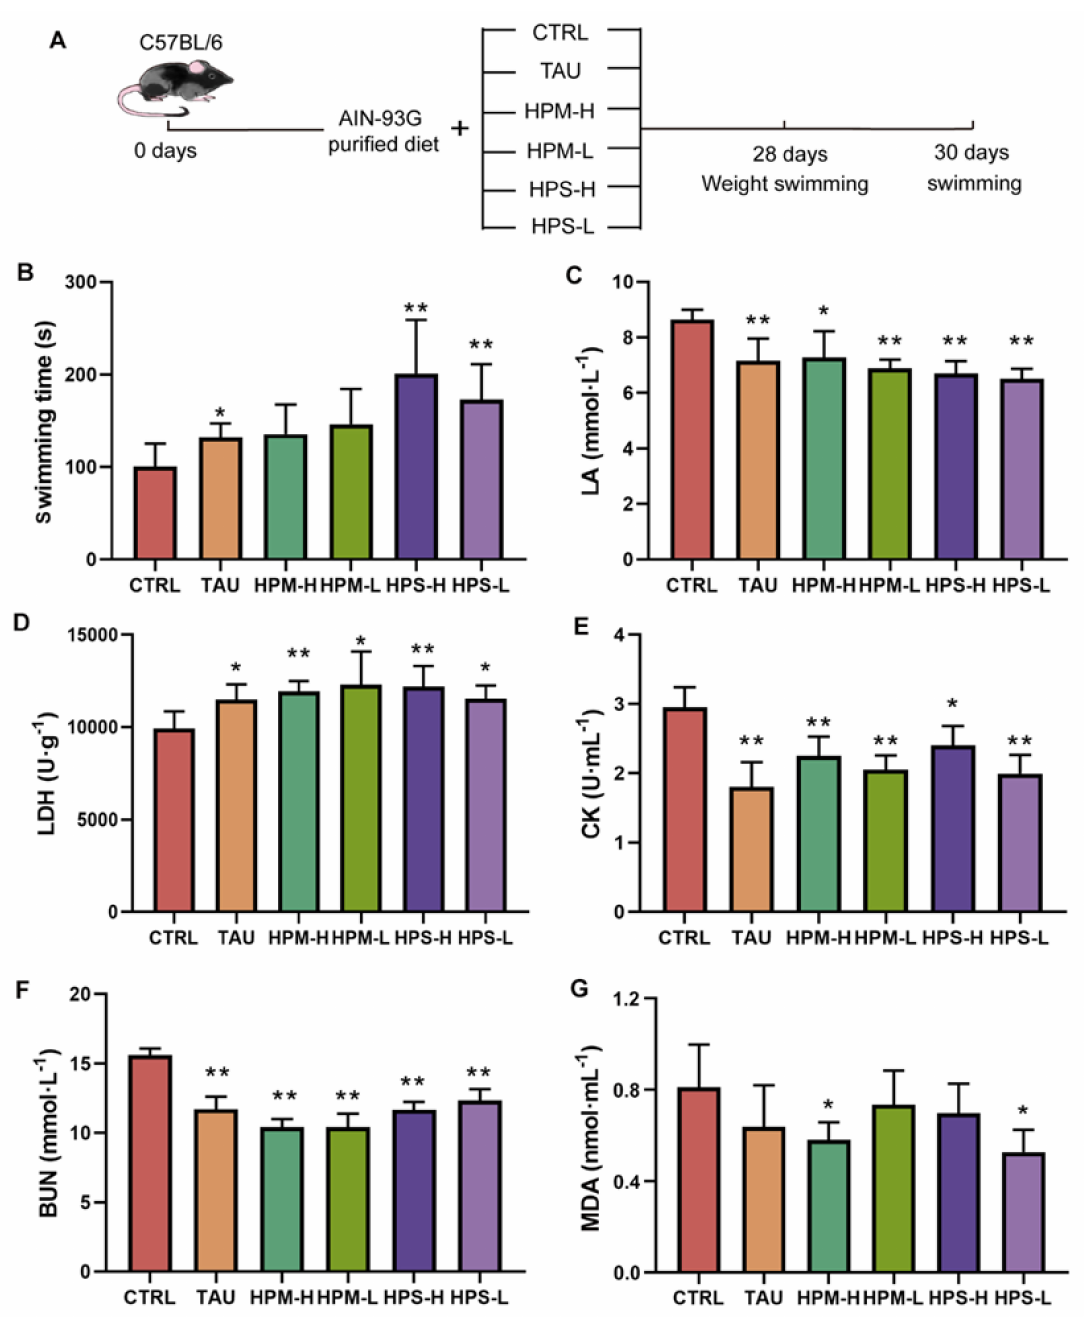
Figure 1. The anti-fatigue effect of the spore and mycelia of Paecilomyces hepiali on mice in each group. ( A ) Study design and diagram. The C57BL/6 mice were divided randomly into six groups. The CTRL group was fed the purified diet (AIN-93G), and the other five groups were fed with AIN-93G plus 0.375% Taurine (TAU group), 0.675% P.hepiali mycelium (HPM-H group), 0.225% HPM (HPM-L group), 0.675% P.hepiali spore (HPS-H group), 0.225% HPS (HPS-L group), respectively. ( B ) Swimming time; ( C ) lactic acid (LA); ( D ) Lactate dehydrogenase (LDH); ( E ) Creatine kinase (CK); ( F ) Blood urea nitrogen (BUN); ( G ) Malondialdehyde (MDA). Data are shown as mean ± SD. Asterisk (*) represents p < 0.05; Asterisk (**) represents p <